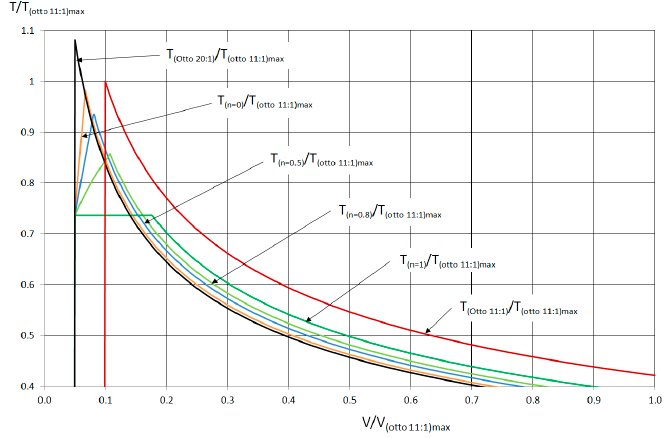
Figure 2. The curve of the maximum temperature in various variants of the proposed theoretical